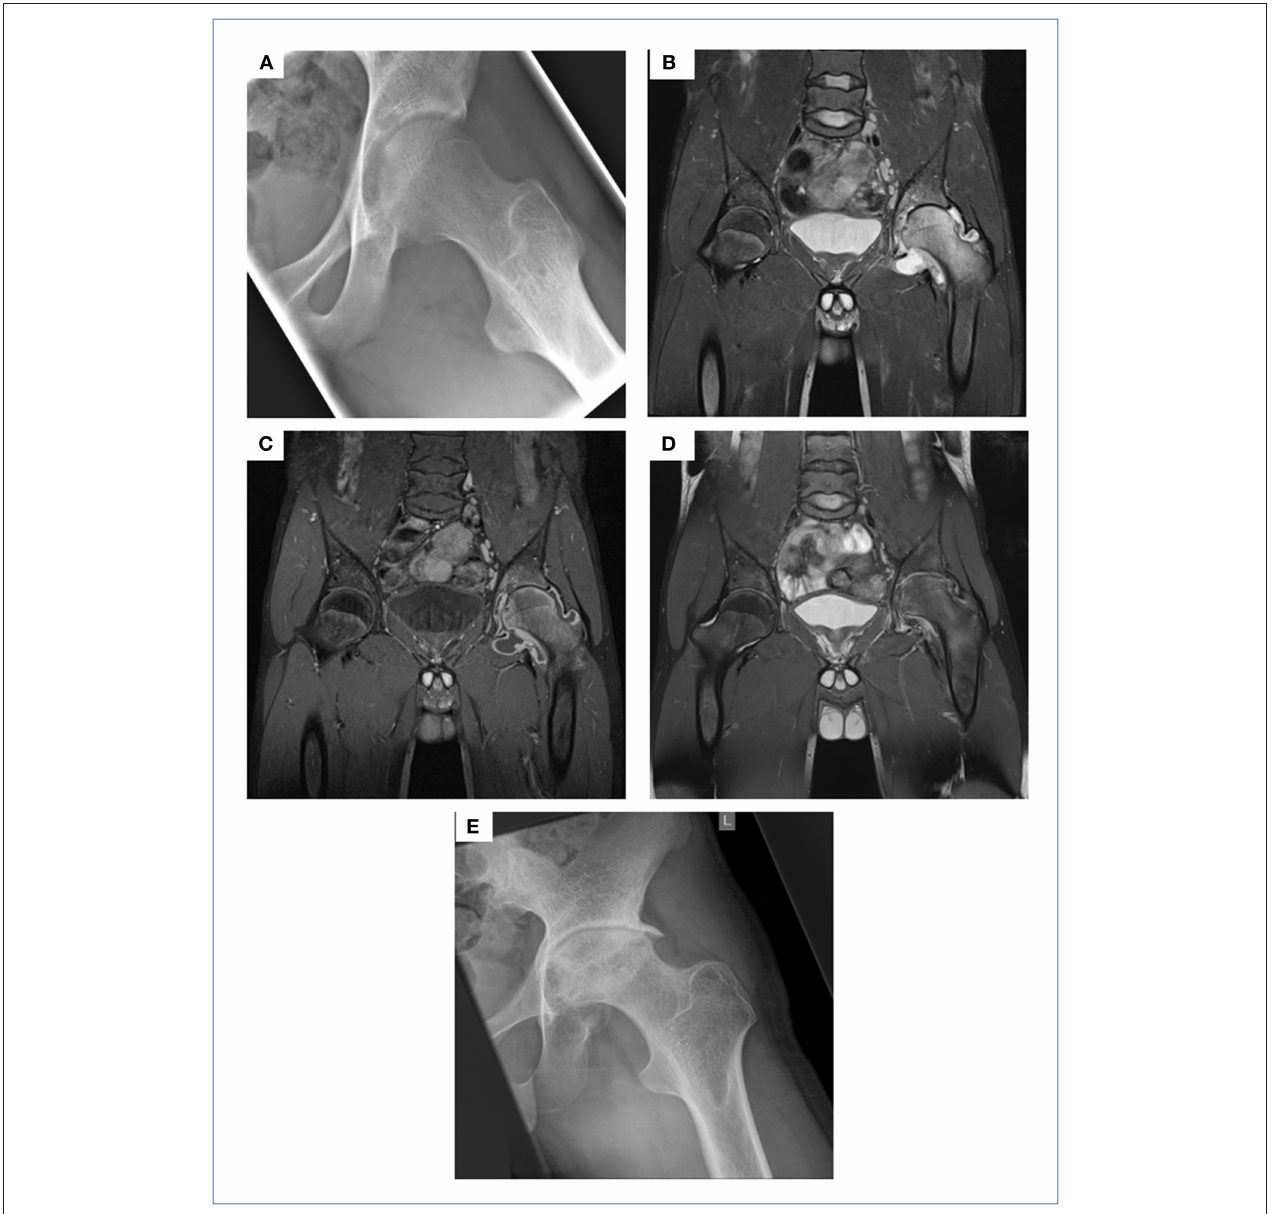
FIGURE 1 | Initial X-ray of the left hip showed blurring of the cortical margins of the femoral head and acetabulum, slight demineralization, and a bulging fat pad surrounding the hip suggesting a joint effusion (A) . On the initial MRI scans there was a hyper intensity of the left hip and acetabulum ( = oedema of the bone marrow) as well as marked joint effusion on the T2 weighted image with fat suppression (B) , synovial thickening and enhancement on the post-contrast T1 weighted image with fat suppression (C) . These MRI findings were receding following 13 months of anti-TB treatment (T2 weighted image with fat suppression, D ) on the one hand, but on the other hand a severe narrowing of the joint space, osteophytes and severe deformity of the femoral head became present. These findings of secondary osteoarthrosis were also demonstrated on the follow-up X-ray few months later (E) .